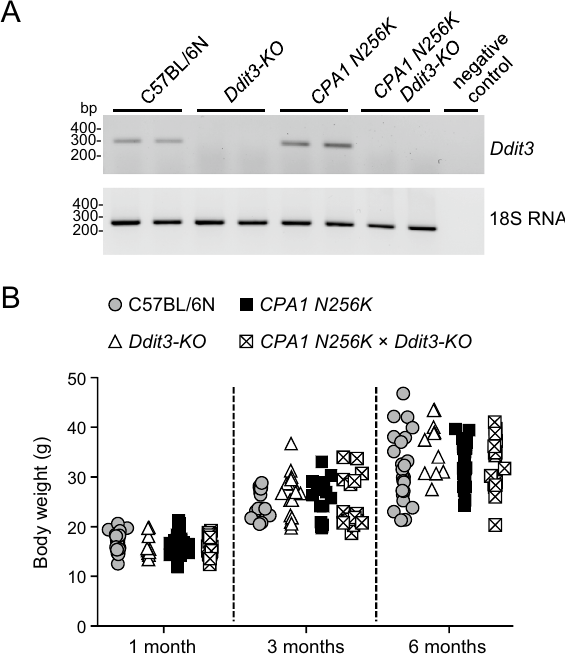
Figure 1. Pancreatic Ddit3 expression and body weight in CPA1 N256K × Ddit3-KO mice. ( A ) Reverse- transcription PCR analysis of Ddit3 mRNA expression in the pancreas of C57BL/6N, Ddit3-KO , CPA1 N256K , and CPA1 N256K × Ddit3-KO mice at 6 months of age. A representative agarose gel picture is shown. See “Methods” for details. ( B ) Body weight of mice at 1, 3, and 6 months of age. C57BL/6N (n = 23, 15, and 25), Ddit3-KO (n = 10, 17, and 12), CPA1 N256K (n = 25, 16, and 25), CPA1 N256K x Ddit3-KO (n = 18, 16, and